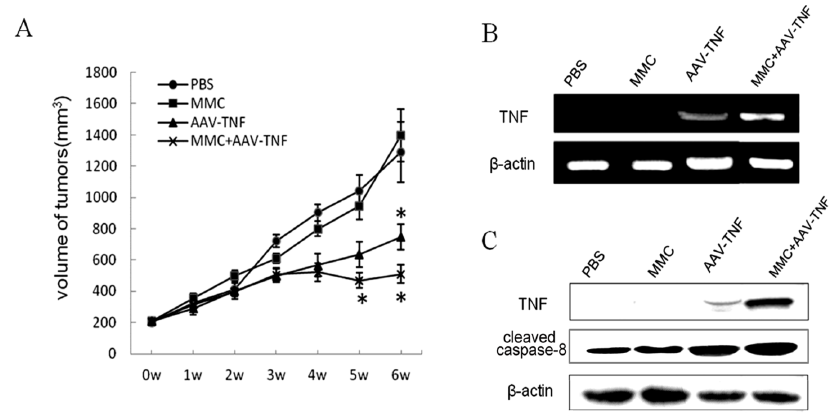
Figure 5. The suppression of tumor growth mediated by AAV- TNF combined with MMC after tumor injection. ( A ) Dynamic suppression of the tumor growth mediated by AAV- TNF and MMC. The mice with subcutaneous glioma xenograft were injected